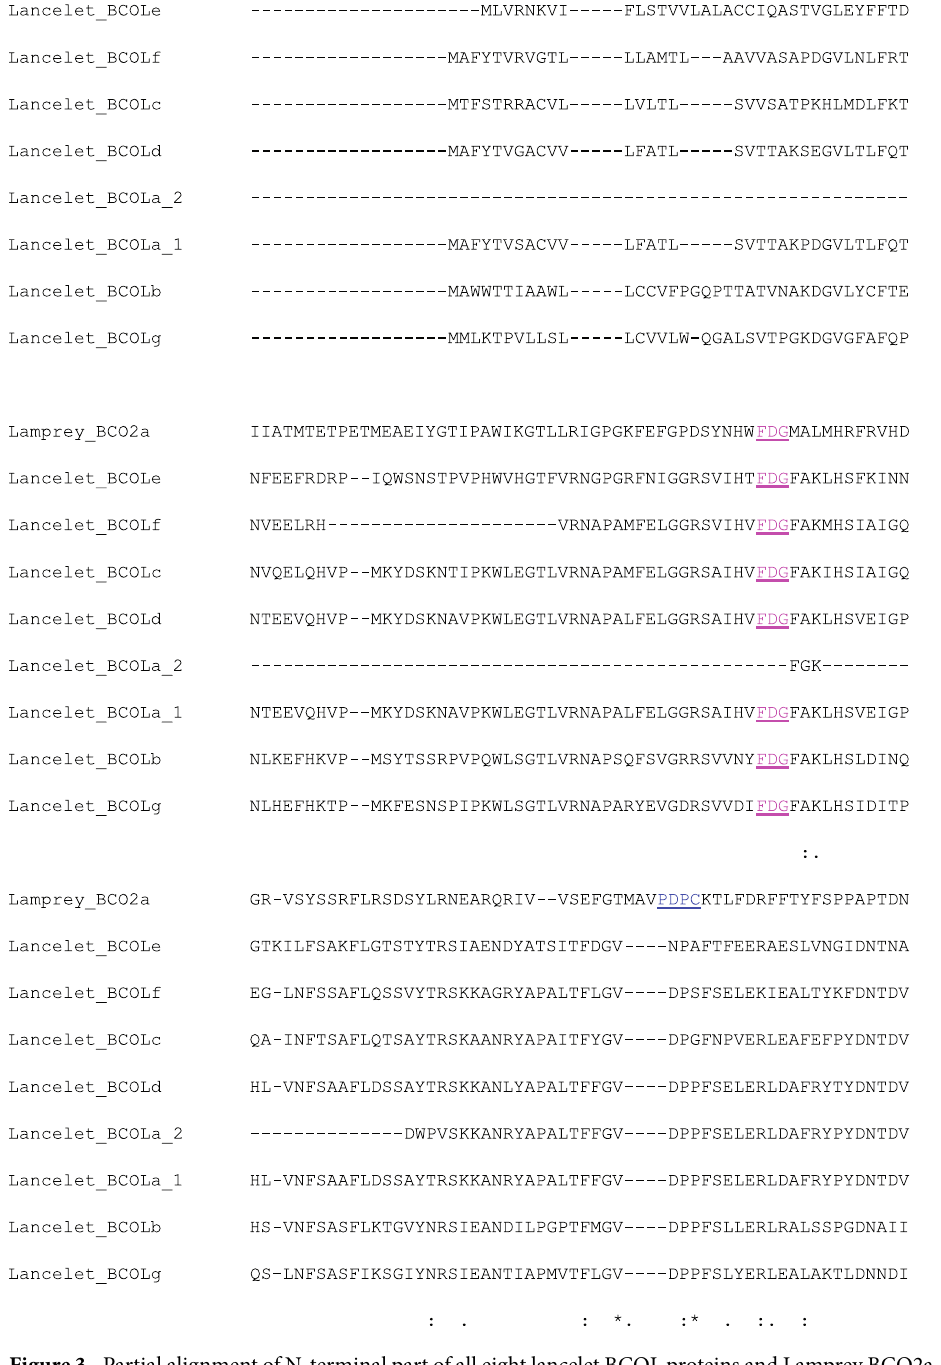
Figure 3. Partial alignment of N-terminal part of all eight lancelet BCOL proteins and Lamprey BCO2a. The FDG motif is shown in purple and the PDPC motif is shown in deep blue. BCOLa_1 (XP_002598440.1, the first BCOL domain, positions 1–512), BCOLa_2 (XP_002598440.1, the second BCOL domain, positions 513–925), BCOLb (XP_002610022.1),_BCOLc (XP_002610868.1), BCOLd (XP_002598424.1), BCOLe (XP_002610869.1), BCOLf (XP_002610867.1), BCOLg (XP_002601288.1), a-g proteins XP